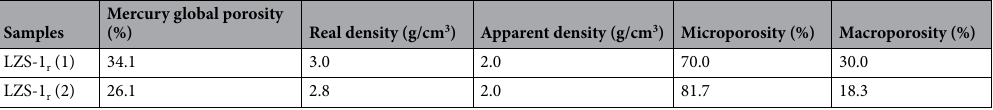
Table 6. Mercury porosimetry test results. 1–2 correspond to the different measurements on the same sample. r indicates that the tests has been performed on a cylindrical rock sample.